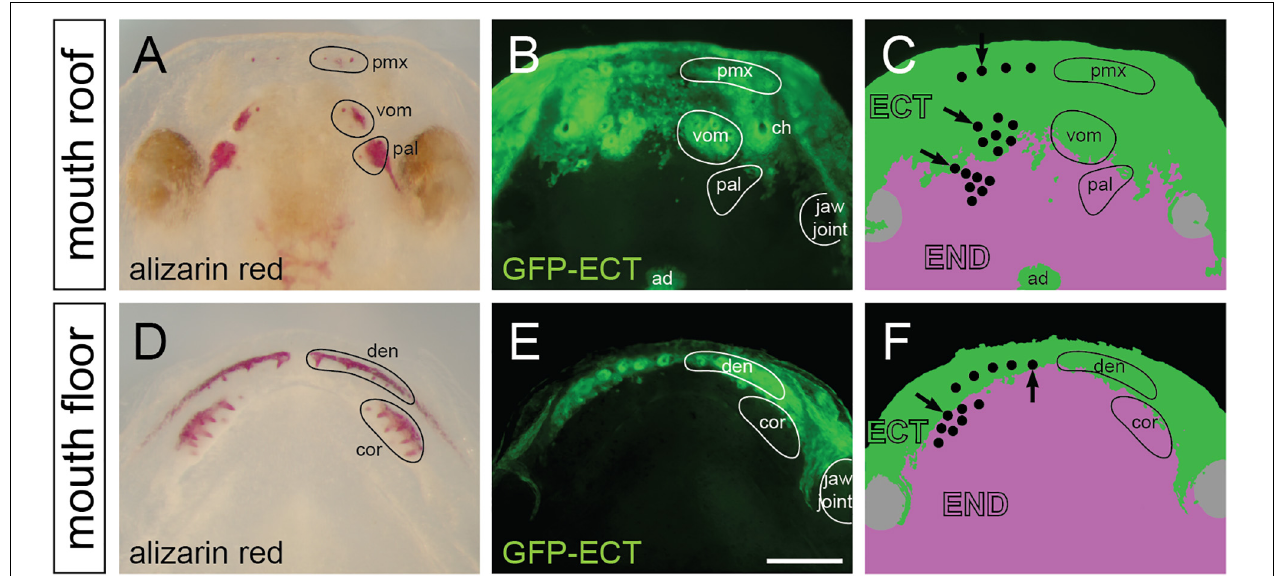
FIGURE 5 | Distribution and epithelial derivation of teeth in the axolotl oral cavity. (A,D) Whole mount larvae at stage 44 dissected at the jaw joint and stained by alizarin red demonstrate developing teeth assembled into premaxillary (pmx), vomerine (vom), and palatine (pal) tooth fields on the mouth roof (A) , and into dentary (den) and coronoid (cor) tooth fields on the mouth floor (D) . (B,C,E,F) Epithelial origin of teeth and schematic interpretation of germ-layer distribution in the axolotl oral cavity (note that only the basal epithelial layer is depicted; the apical layer of the oral epithelium is derived from endoderm). Black dots in C and F represent individual teeth, and positions of initiator-teeth of each tooth field are labeled with black arrows. Teeth developing at the ecto-endoderm boundary are found in vomerine, palatine, dentary, and coronoid tooth fields. ad, adenohypophysis; ch, choana (inner nostril); den, dentary teeth; ECT, ectoderm; END, endoderm; pal, palatine teeth; pmx, premaxillary teeth; cor, coronoid teeth; vom, vomerine teeth. Scale bar equals 500 µ